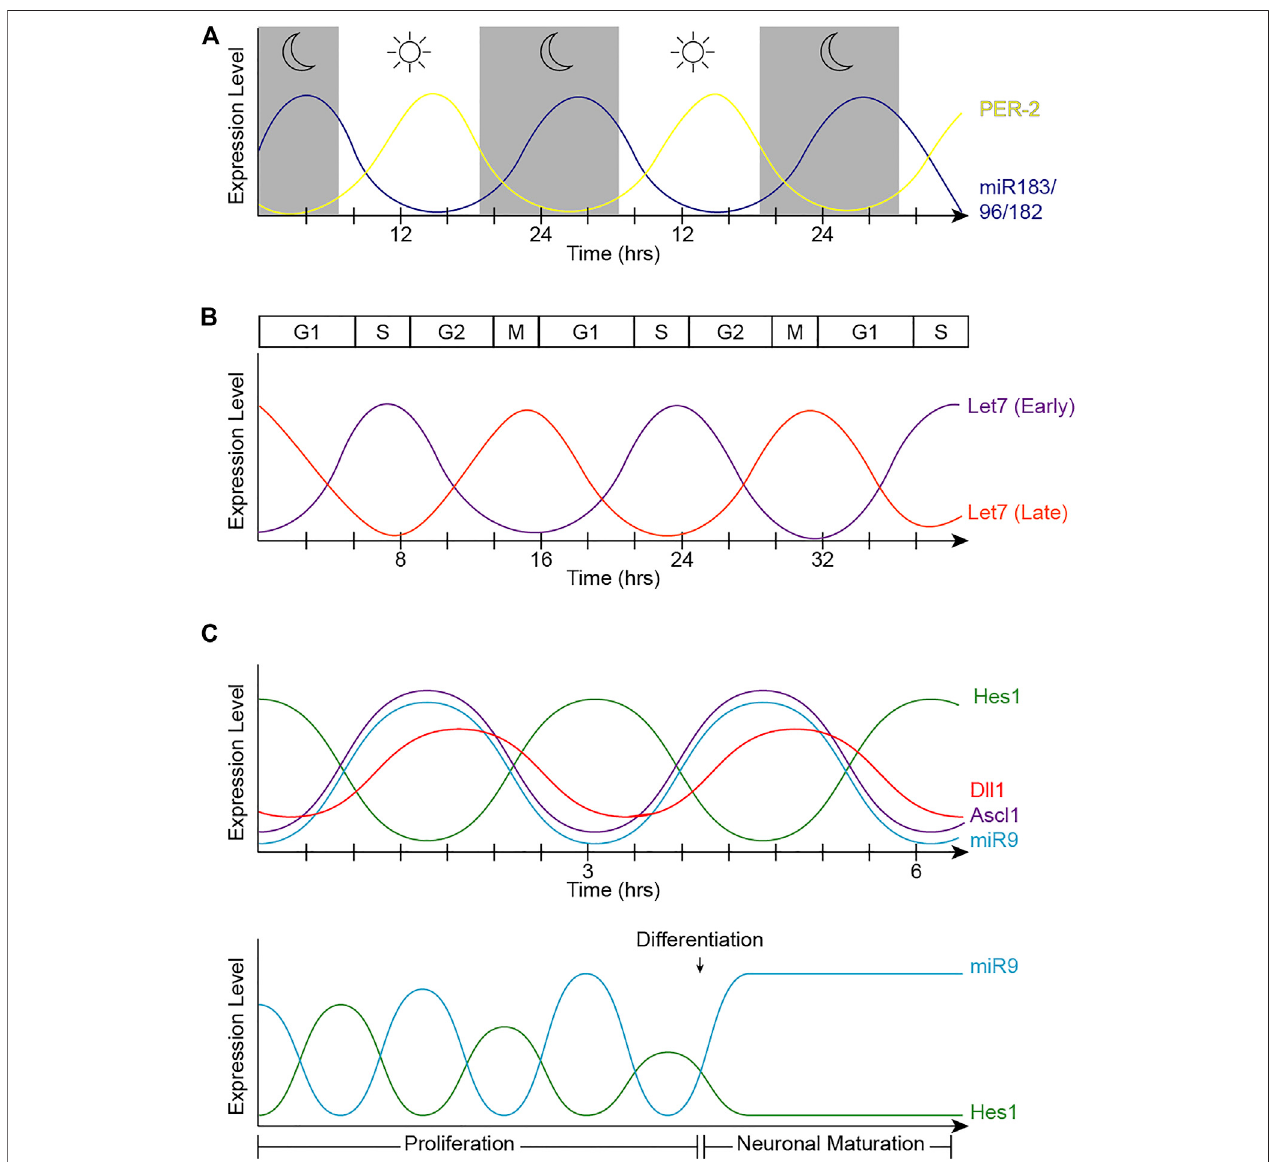
FIGURE2| OscillatorypatternsofmiRNAsinbiologicalprocesses. (A) OscillatorybehaviorofthemiR-183complex.miR-96directlytargetsPER2,causinganout- of-phaseoscillationpatternwithPER-2peakingduringlightandmiR-183/96/182peakingindarkhours. (B) Let-7oscillatorybehavior.The fl uctuationoflet-7expression inaccordancewiththecellcyclechangesatdifferentstagesofdevelopment. Earlyindevelopment(let-7early),let-7expression isatitslowestatthestartofthecellcycle in G1, and peaks inS-phase. The phase ofoscillation shiftslater indevelopment(let-7 late),when let-7 expression isat its highest inmitosisand lowest inS-phase. (C) Hes1/miR-9 ultradian oscillator.(Top)Hes1 oscillation isself-drivenwitharhythmicityof2 – 3 h.TheHes1oscillatorrepressesAscl1andNotch ligands,consequently driving their oscillation patterns. MiR-9 and Hes1 participate in a negative feedback loop. (Bottom) Hes1 and miR-9 have out-of-phase expression patterns and are dependent on one another. As miR-9 continues to accumulate during proliferation, Hes1 is consequently dampened. RPC differentiation is induced when miR-9 levels reach a threshold to maintain high, steady levels while dulling Hes1 oscillations, resulting in neuronal maturation.